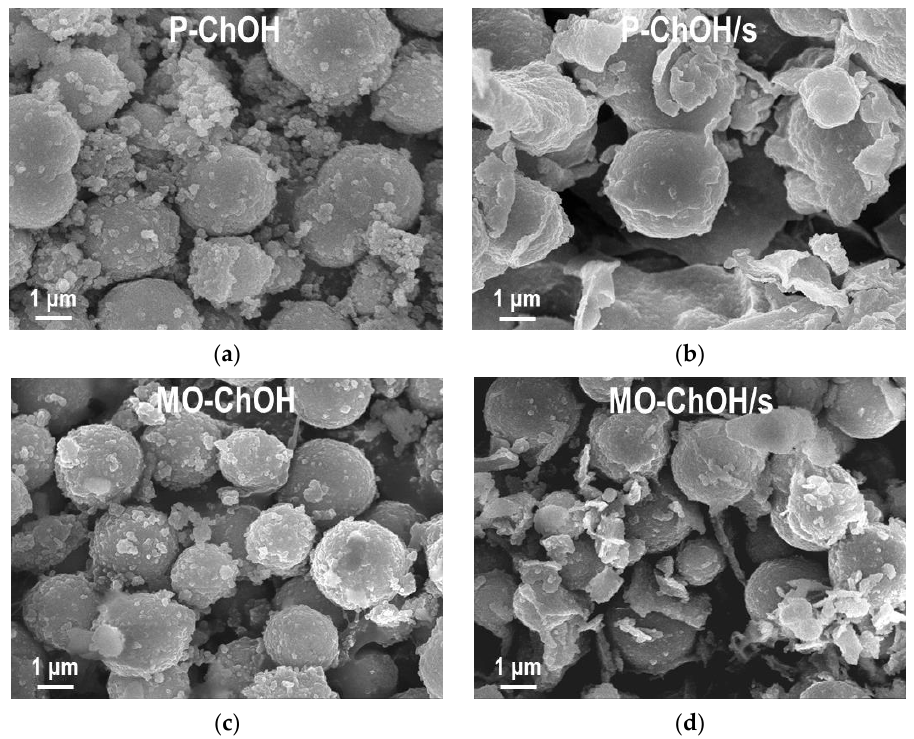
Figure 4. SEM images of precursors and calcined mixed-oxide materials obtained with ChOH precipitant, without or with starch: ( a ) P-ChOH; ( b ) P-ChOH/s; ( c ) MO-ChOH; ( d ) MO-ChOH/s. Magnification × 10,000.